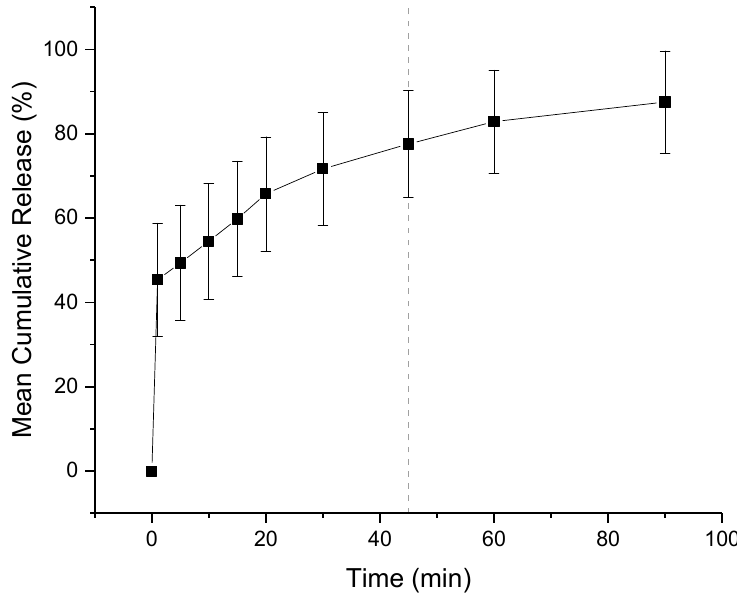
Figure 10. Dissolution profile in pH 1.2 co-axial formulation of KCT and CPM in the core, and E-EPO in the shell. The dashed line represents 45 min.